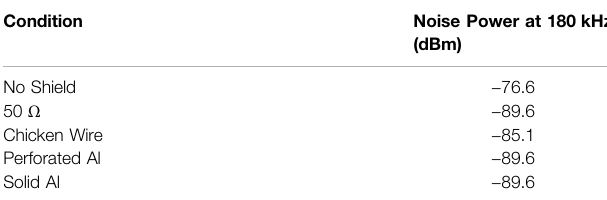
TABLE 4 | Shield effectiveness